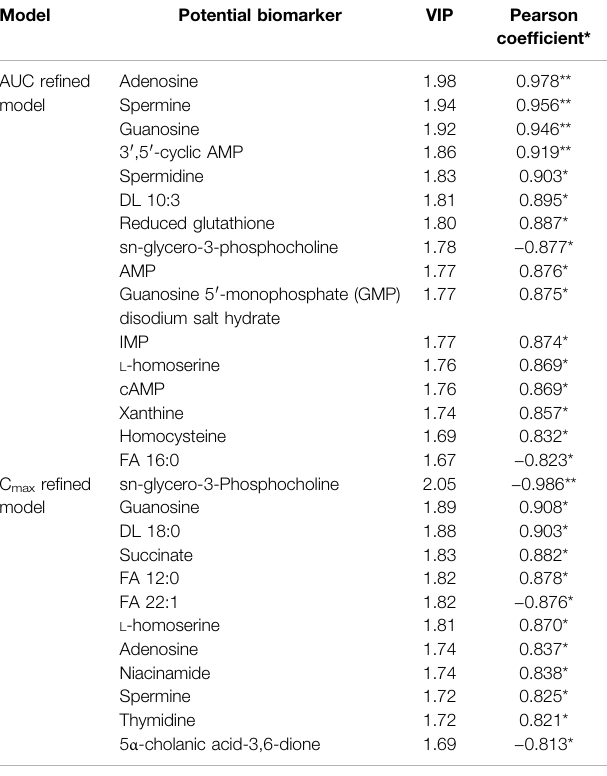
TABLE 1 | Potential predictive biomarkers for the pharmacokinetics of Nuc.